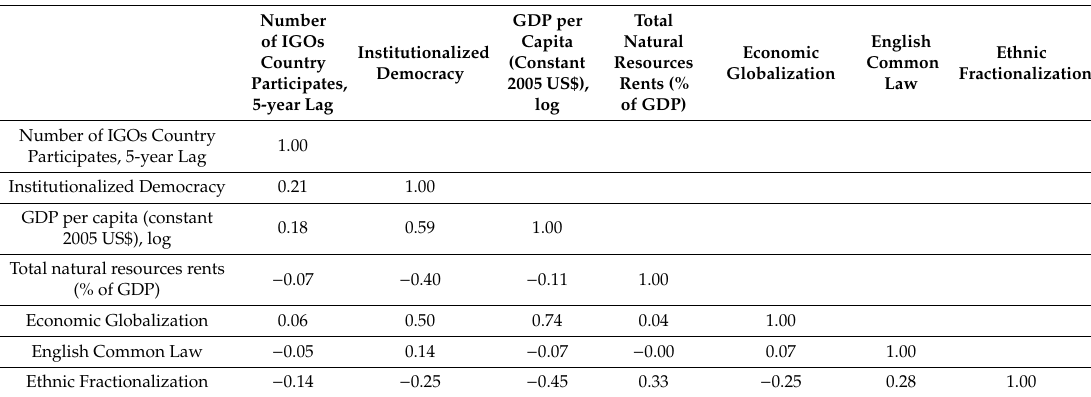
Table A3. Correlations among independent variables.